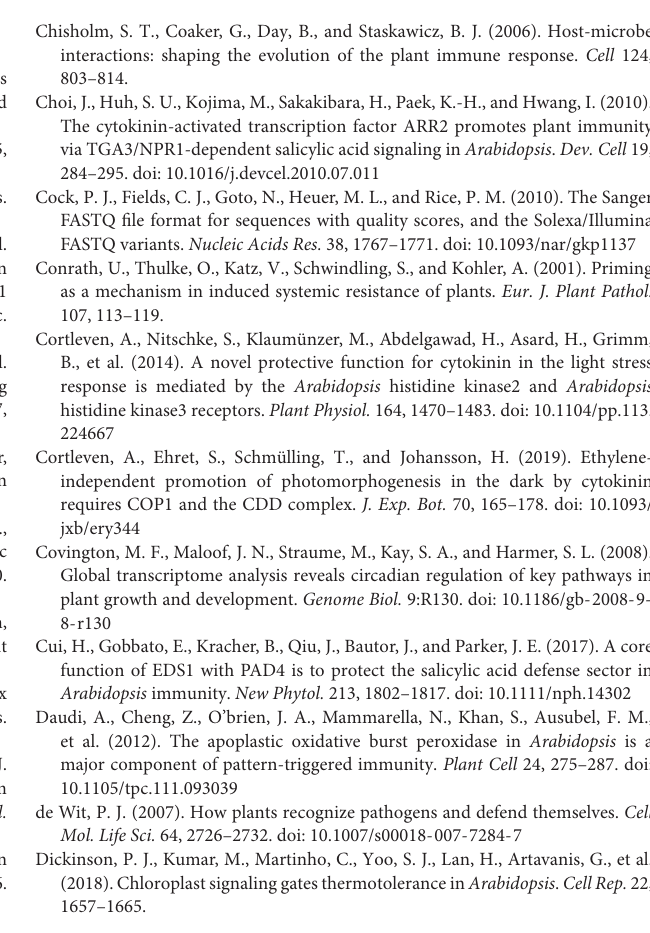
Supplementary Figure 4 | Photoperiod stress causes a strong transcriptional regulation of genes coding for enzymes involved in the scavenging of ROS. 5-week-old short-day (SD)-grown plants were exposed to a prolonged light period (PLP) of 32 h followed by a normal SD night. The experimental setup is shown in Figure 1A . (A) QT clustering of genes encoding enzymes involved in the scavenging of ROS (Pearson’s correlation). Three clusters are found: cluster 1 showing upregulation of genes over time, cluster 2 showing downregulation of genes over time and cluster 3 showing a strongly increased expression at time points 4 and 6 h. Depicted are the ratios of PLP vs. control plants for each genotype and time point. A complete list of the genes coding for scavenging enzymes used in this analysis including their expression levels is provided in Supplementary Data 6 . Supplementary Figure 5 | Photoperiod stress results in transcriptional regulation of jasmonic acid biosynthesis and signaling. Hierarchical clustering of genes involved in jasmonic acid (JA) biosynthesis and signaling (Pearson’s correlation). An overview of the regulation of these JA biosynthesis and signaling genes after photoperiod stress treatment is provided in Supplementary Data 9